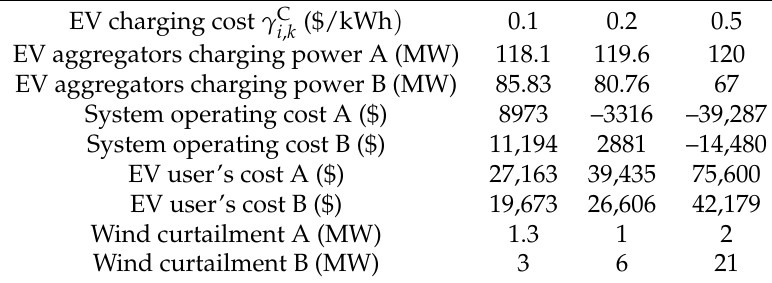
Table 5. Contrast of two strategies under different charging prices at